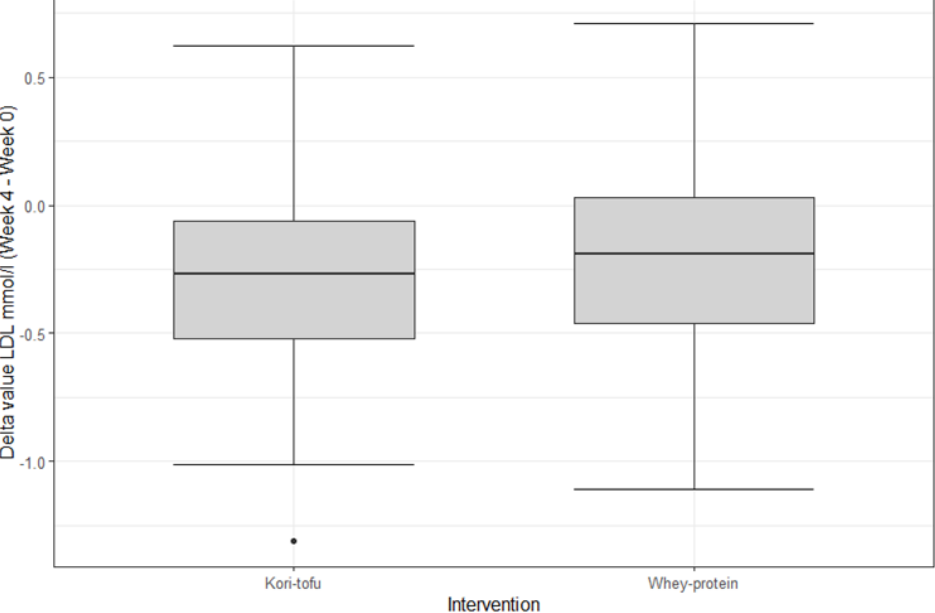
Figure A3. Delta values of HDL cholesterol (mmol/l) per intervention (values week 4 – values week 0). Boxplots represent the 25th, 50th (median) and 75th percentile. Antennas represent 1.5 times interquartile range. Dots represent values outside the 1.5 times interquartile range.